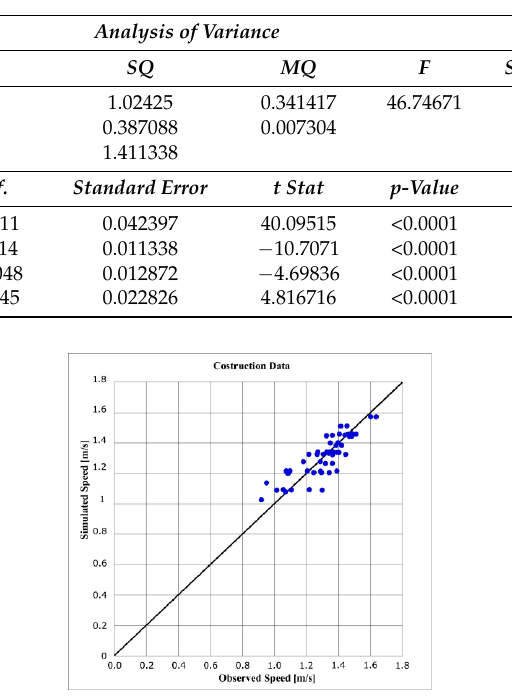
Figure 4. Global model. Comparison between observed and simulated speeds.